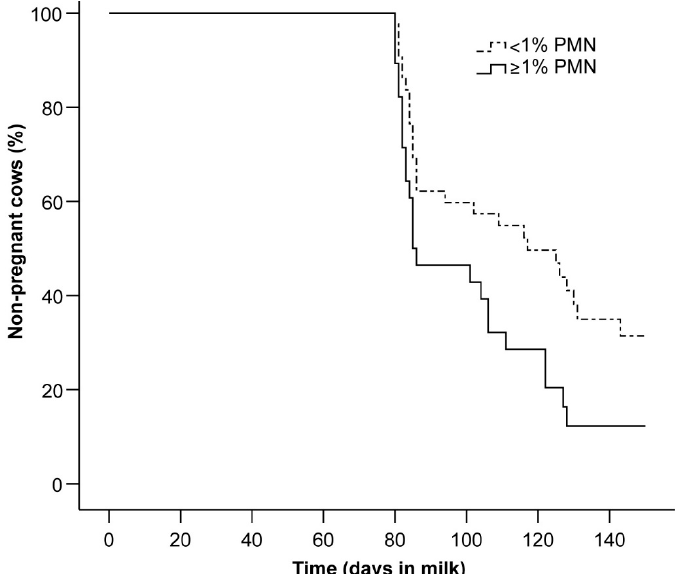
Figure 3. Kaplan–Meier survival curves for the percentage of non-pregnant cows until 150 days in milk for animals with PMN ≥ 1% or PMN < 1%. The percentage of cows removed from the analysis because they were excluded from breeding after the first ( n = 1) or second ( n = 6) AI was 3.6% (1/28) for PMN ≥ 1% and 14% (6/43) for PMN < 1%.